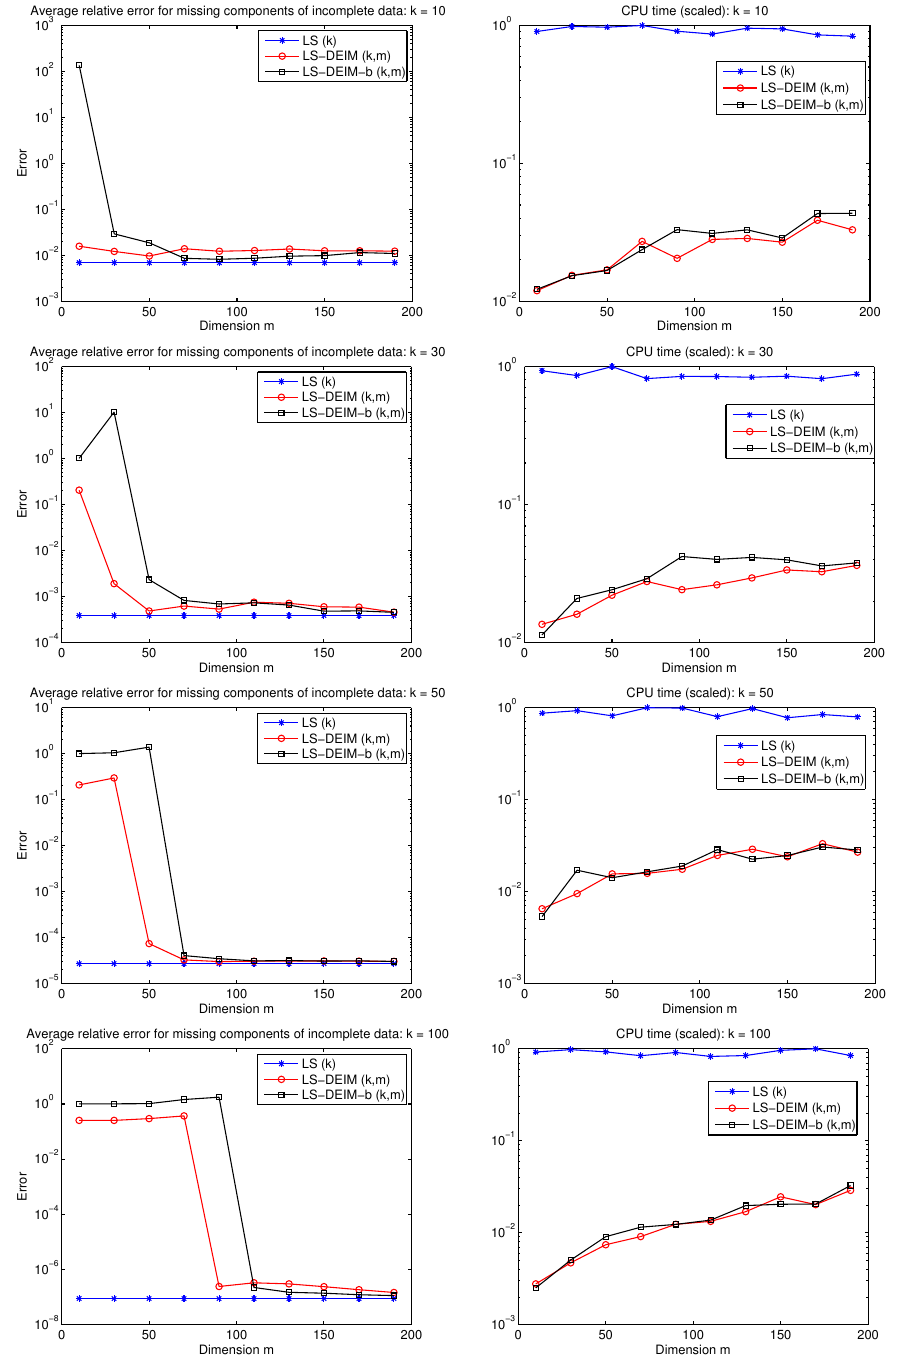
Figure 9. (Numerical Test 3) Average relative error of the reconstructed missing components using the standard LS method and the accelerated least-squares with basis from rSVD, denoted by LS-DEIM for case (i) and LS-DEIM-b for case (ii) defined in Algorithm 4 for POD dimensions k = 10,30,50 with DEIM dimensions m = 10,30,50,70,90,110,130,150,170,190. To clearly illustrate the effect of dimension k on the POD basis, Figure 10 compares the average relative error and the corresponding CPU time used in the reconstruction from the accelerated POD-LS approach using m = k with the ones from the standard POD-LS approach for each k ranging from 10 to 190. Figure 10 shows that the accelerated POD-LS approach can provide almost the same accurate reconstruction as the standard POD-LS roughly 100 times faster. This numerical test, therefore, demonstrates the potential of the proposed approach for other large-scale